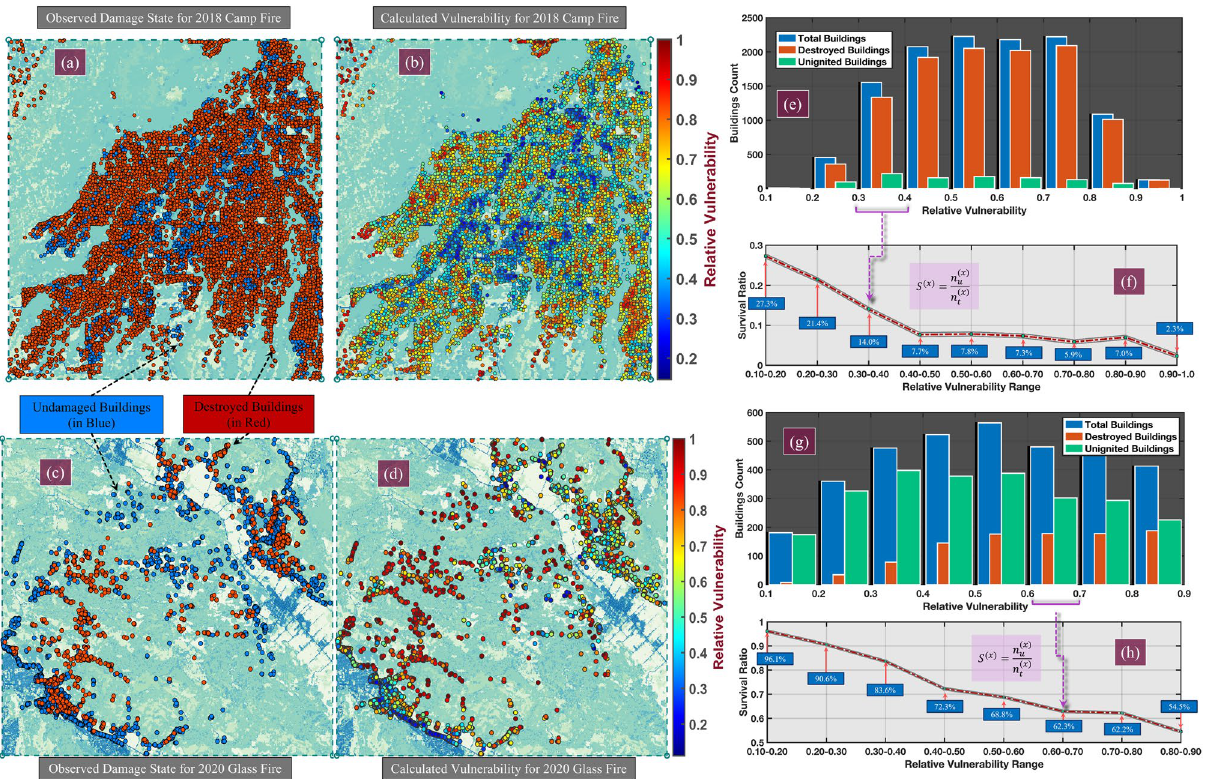
Figure 4. ( a ) Observed damage states of individual structures for Camp Fire. Blue represents undamaged/ minimally damaged and red represents significantly damaged structures. ( b ) Relative vulnerability map evaluated for Camp Fire. ( c ) Observed damage states of individual structures for the Glass Fire. ( d ) Relative vulnerability map evaluated for the Glass Fire. ( e ) Distribution of damaged, undamaged and total buildings based on the calculated relative vulnerability for the Camp Fire. ( f ) Survival plot calculated from the distribution plot for the Camp Fire. ( g ) Distribution of damaged, undamaged, and total buildings based on the calculated relative vulnerability for the Glass Fire. ( h ) Survival plot calculated from distribution plot of Glass Fire. All maps were developed in QGIS 49